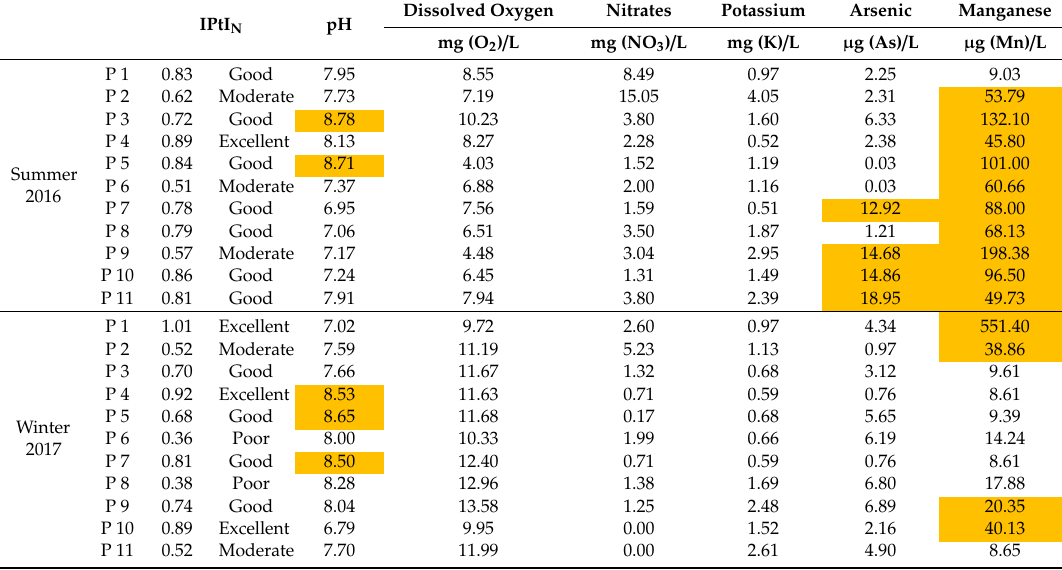
Table 2. Characterization of sampling sites surface water parameters and ecological integrity (IPtI N ). In orange are highlighted the exceedances above Portuguese legislation thresholds and WFD